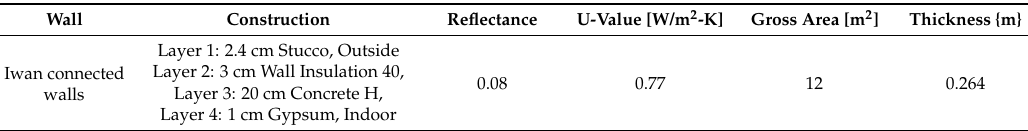
Table 4. The thermal characteristics of walls.